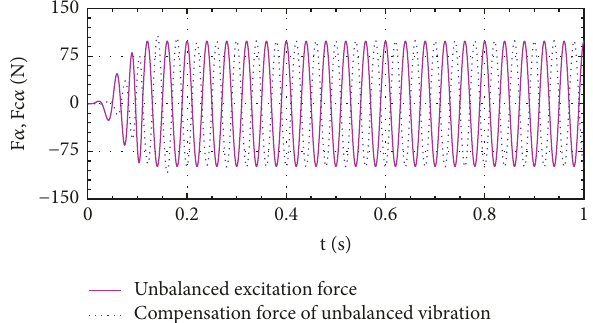
Figure 8: Comparison curves between the unbalanced excitation force and the vibration compensation